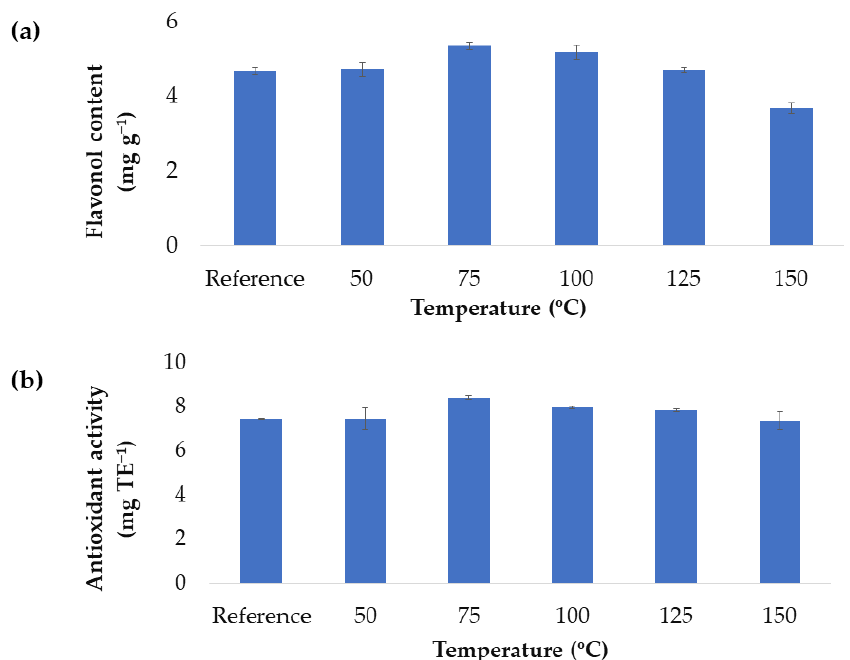
Figure 2. The effect from different temperature levels on the flavonols content ( a ) and on the antioxidant activity of the onion extracts ( b ). Each extraction was conducted in triplicate (mean ± SD) and the statically significant differences between the temperatures according to the Tukey’s test ( p -value < 0.05) are indicated by the different letters over the corresponding column.